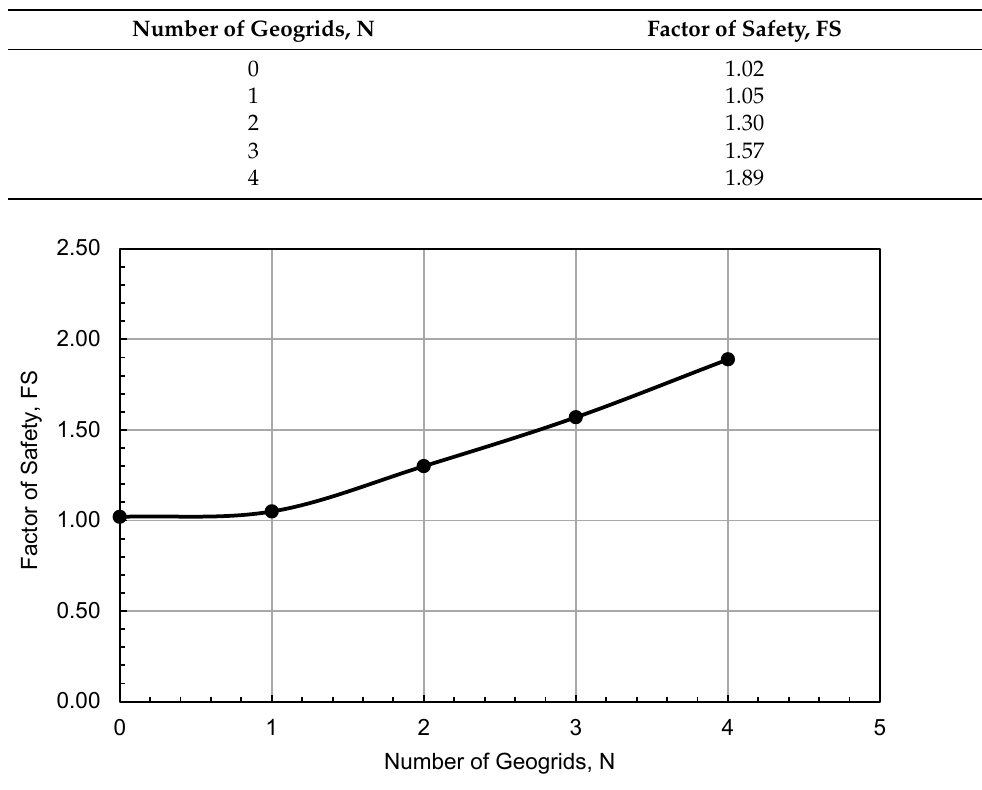
Figure 13. Variation in FS with N (1V/2H slope) (LEM).